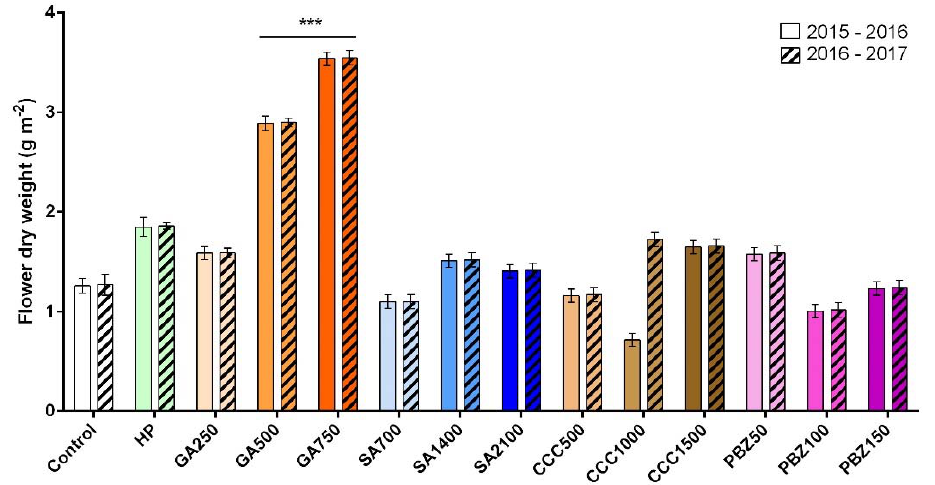
Figure 3. Effects of corm priming with distilled water and four different growth regulators on flower dry weight of saffron plants grown under field condition. HP, hydropriming; GA, gibberellic acid; SA, salicylic acid; CCC, chlormequat chloride; PBZ, paclobutrazol. Data are shown as mean ± standard deviation; *** p < 0.001 vs. control group. The empty white and colored columns correspond to the data for the years 2015–2016. The white and colored columns with oblique lines correspond to the years 2016–2017.